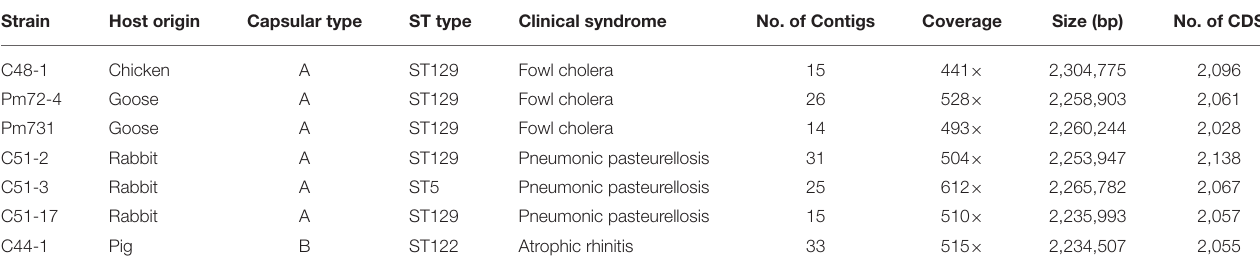
TABLE 1 | Summary of genome assembly and gene calling of sequenced P. multocida strains.